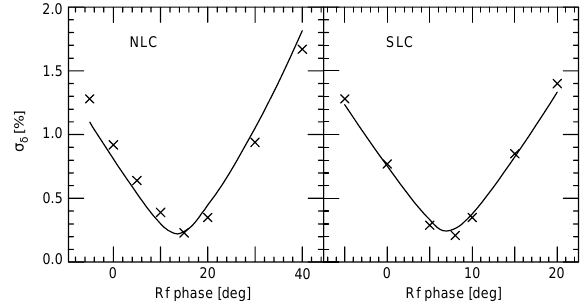
FIG. 3. rms energy spread versus average rf phase in the NLC and SLC linacs (solid) compared with Eq. (25) (crosses). The NLC linac has N (cid:1) 1 3 10 10 , s z (cid:1) 140 m m, G (cid:1) 57 MV (cid:2) m, and 11.424 GHz rf structures having an a (cid:2) l (cid:1) 0.18 while the SLC linac has N (cid:1) 3 3 10 10 , s z (cid:1) 1 mm, G (cid:1) 17 MV (cid:2) m, and 2.856 GHz rf structures having an a (cid:2) l (cid:1) 0.12 .